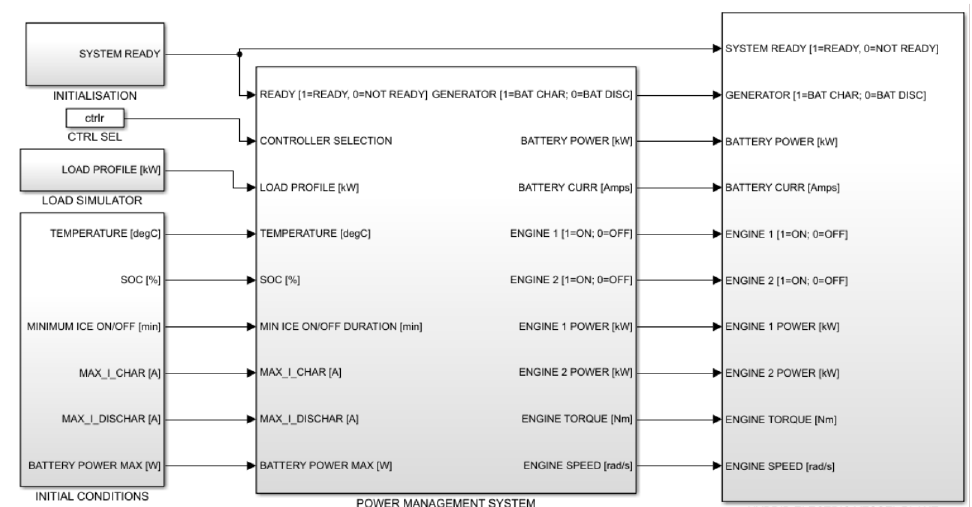
Figure A1. Matlab/Simulink model for SCALEXIO.